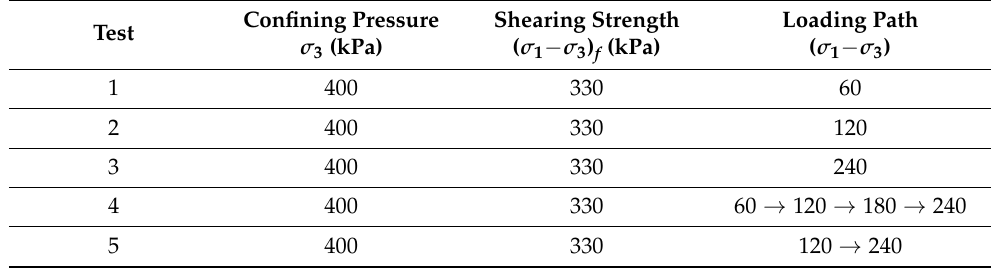
Table 2. Triaxial creep test plan.